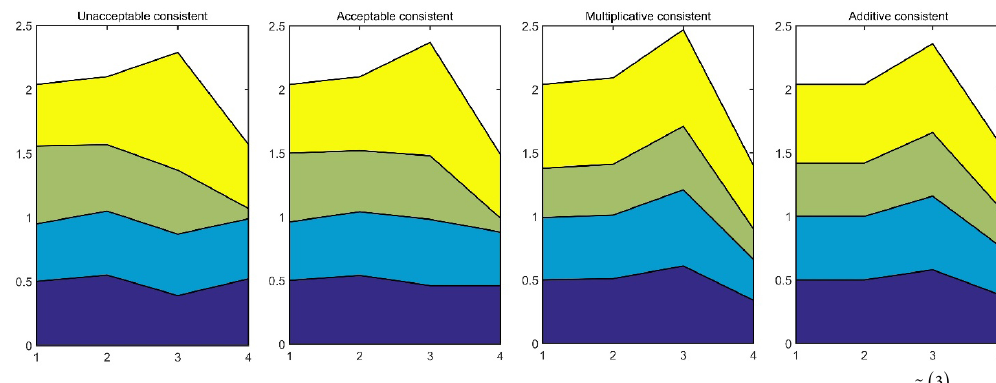
Figure 7. Areas of unacceptable, acceptable, multiplicative and additive consistent DHHFLPR of